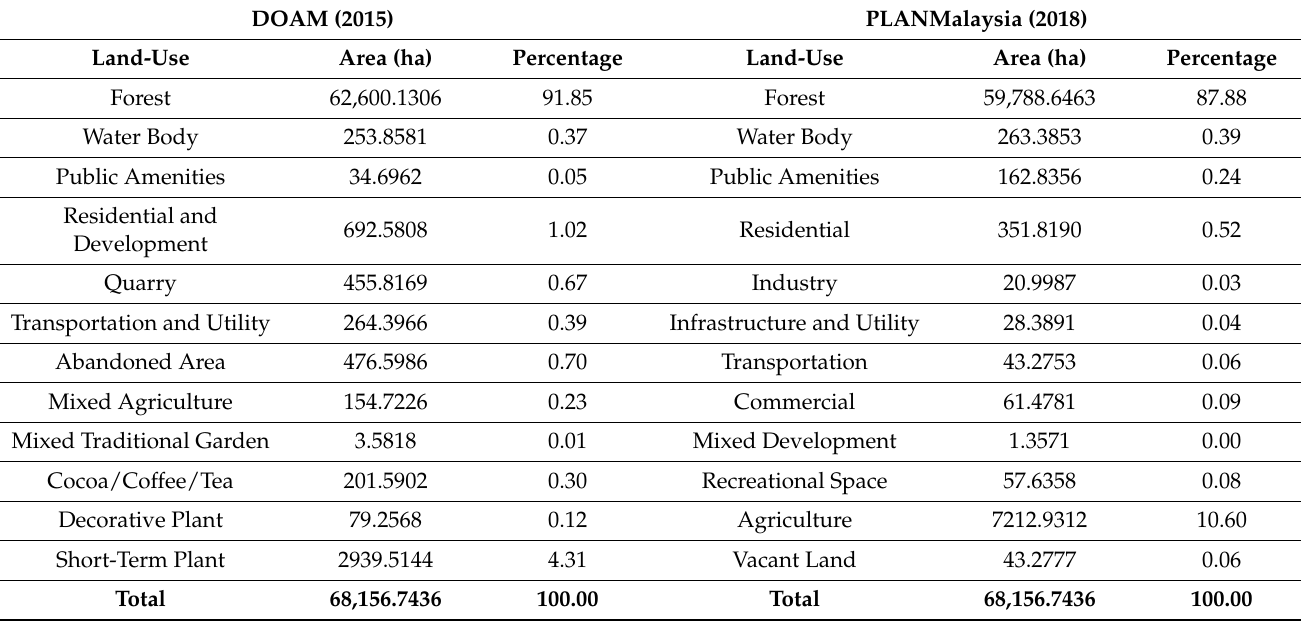
Table 1. Details of land use activities in Cameron Highlands